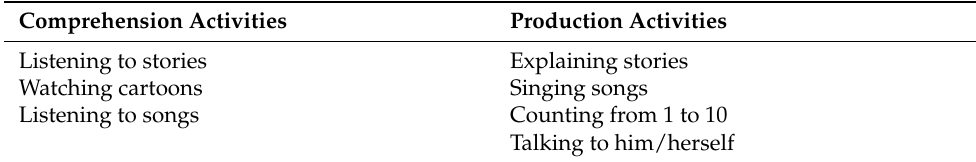
Table 9. Comprehension and production activities by younger children